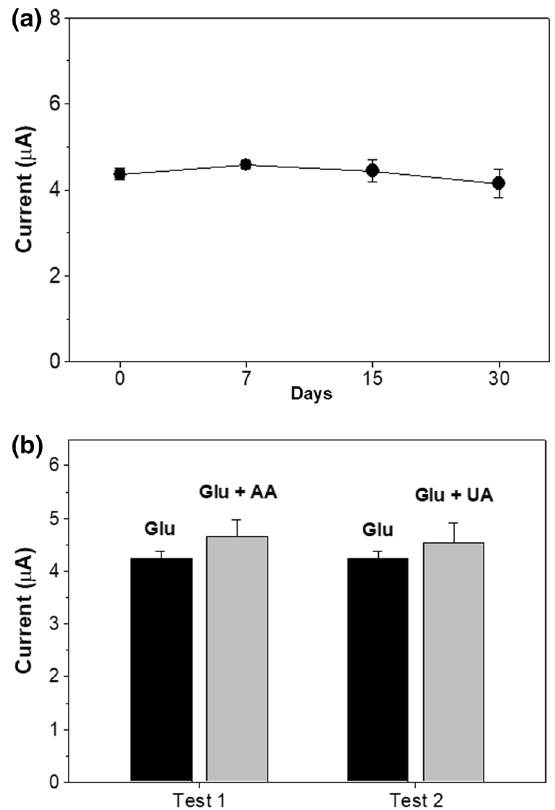
Fig. 6 a Long‑term stability and b selectivity of glucose biosensor. Chronoamperometry responses were recorded in a 4 mM glucose solution with/without 0.1 mM interfering species (AA and